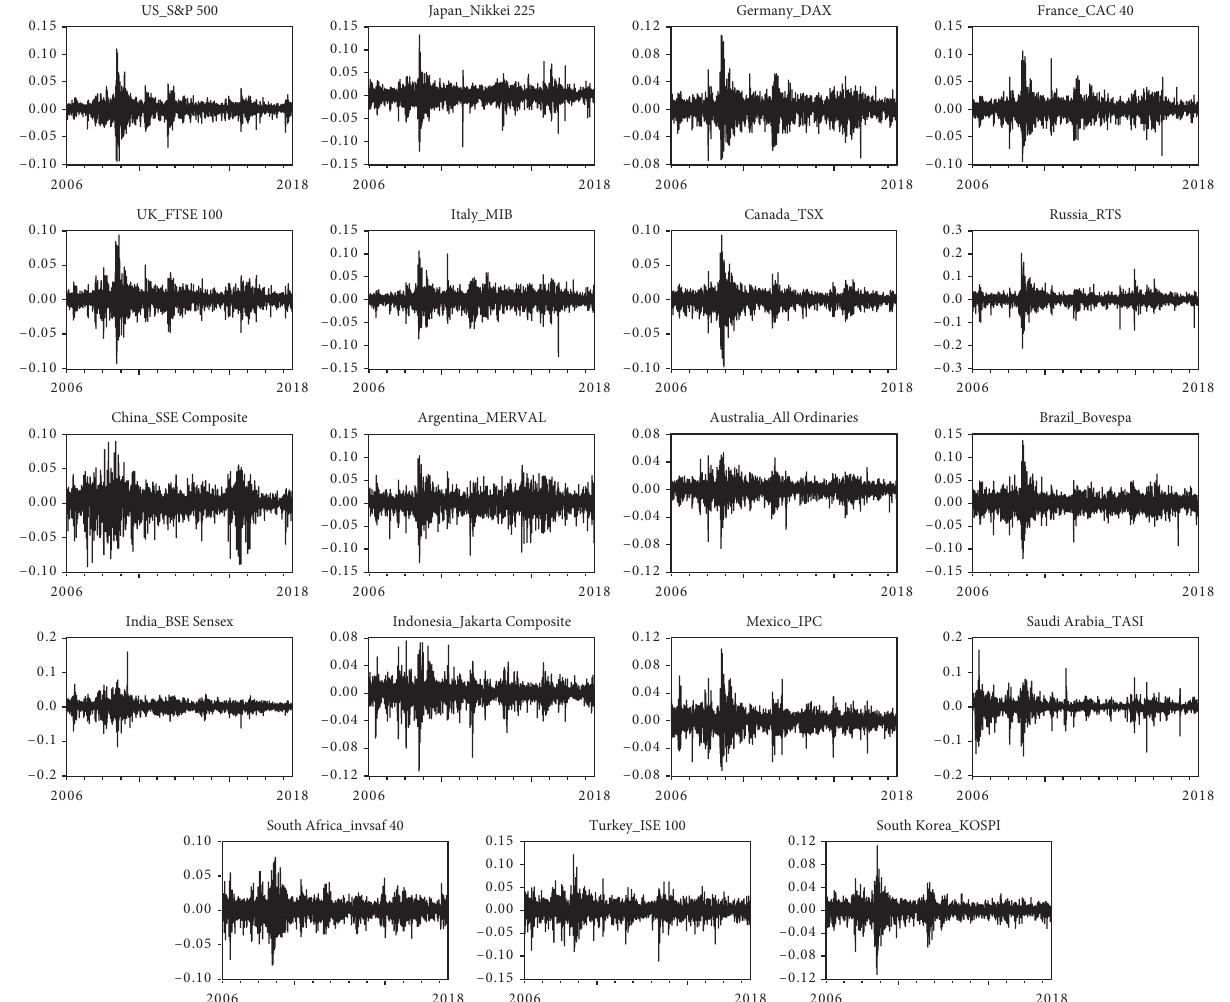
Figure 3: The volatility characteristics of G20 stock returns. (a) US_S&P 500, (b) Japan_Nikkei 225, (c) Germany_DAX, (d) France_CAC 40, (e) UK_FTSE 100, (f) Italy_MIB, (g) Canada_TSX, (h) Russia_RTS, (i) China_SSE Composite, (j) Argentina_MERVAL, (k) Aus- tralia_All Ordinaries, (l) Brazil_Bovespa, (m) India_BSE Sensex, (n) Indonesia_Jakarta Composite, (o) Mexico_IPC, (p) Saudi Ara- bia_TASI, (q) South Africa_INVSAF 40, (r) Turkey_ISE 100, and (s) South